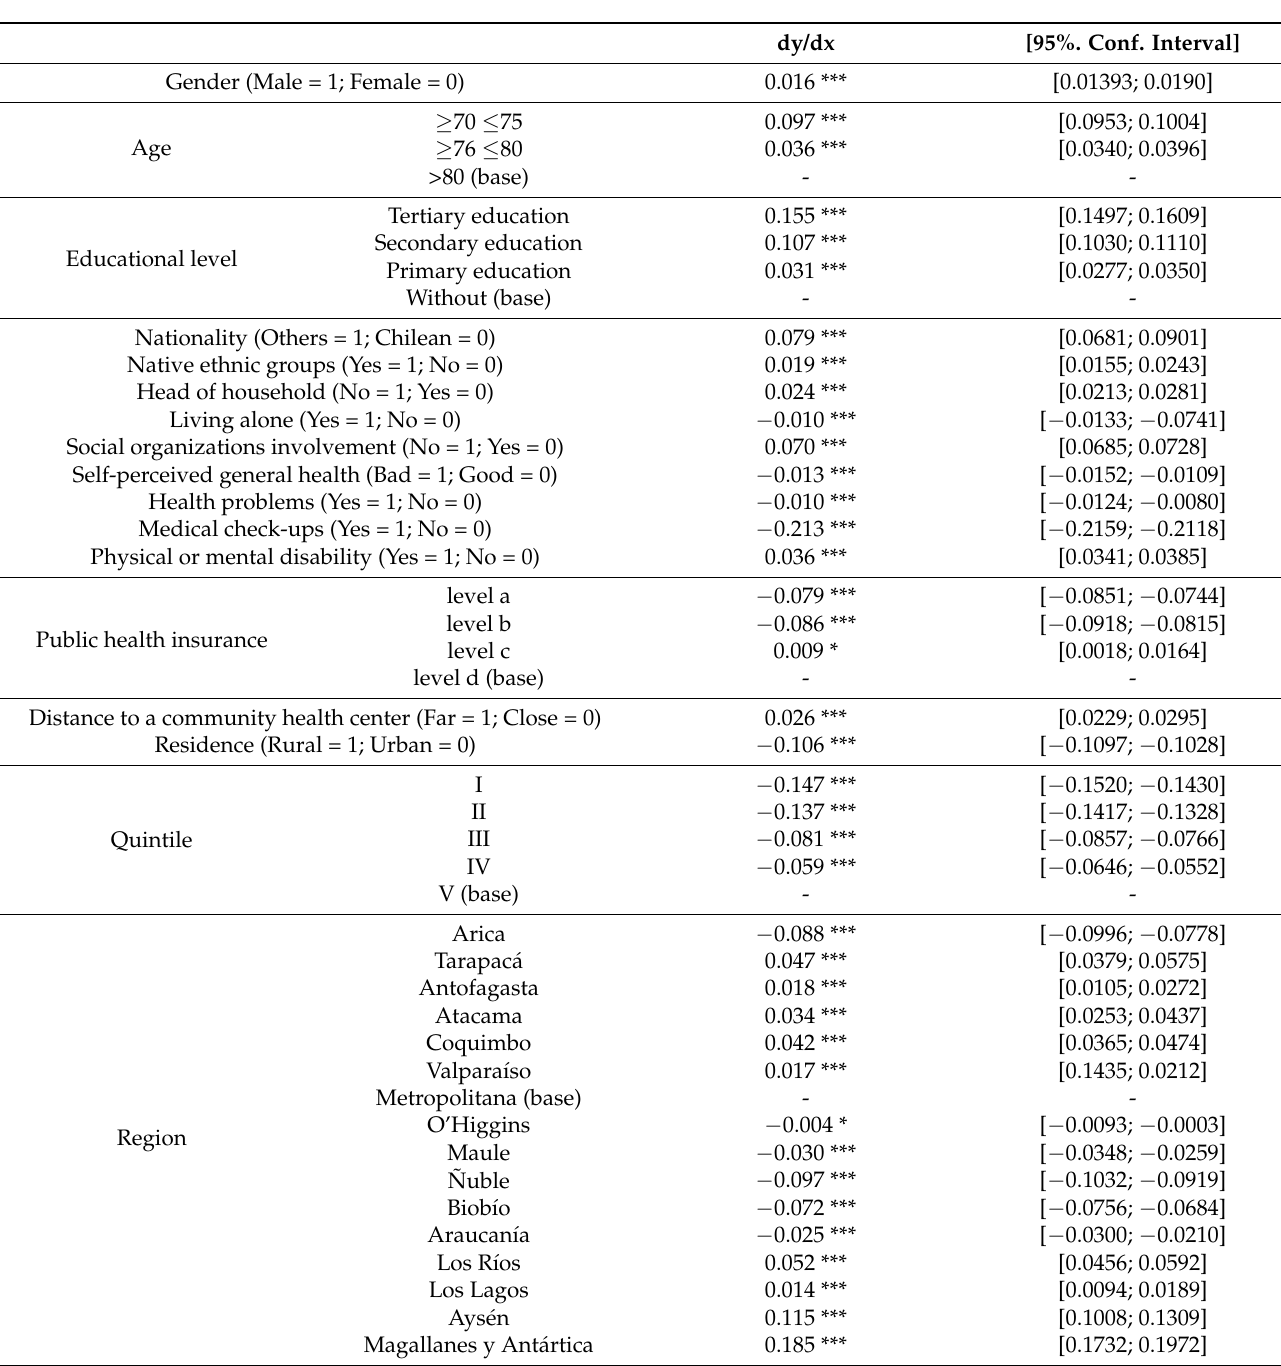
Table 1. Predict (the older person did not withdraw